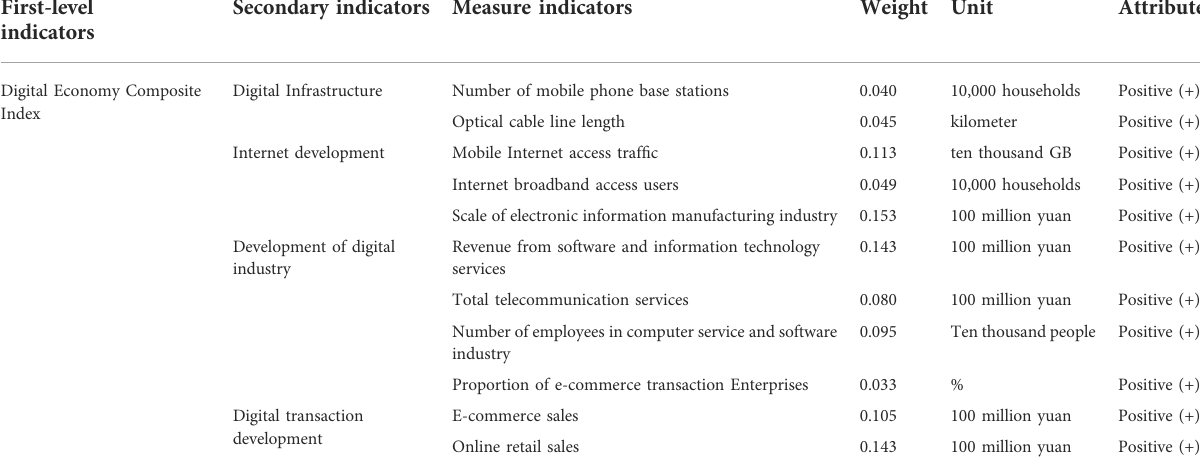
TABLE 2 Composition and weight distribution of comprehensive index system for digital economic development.